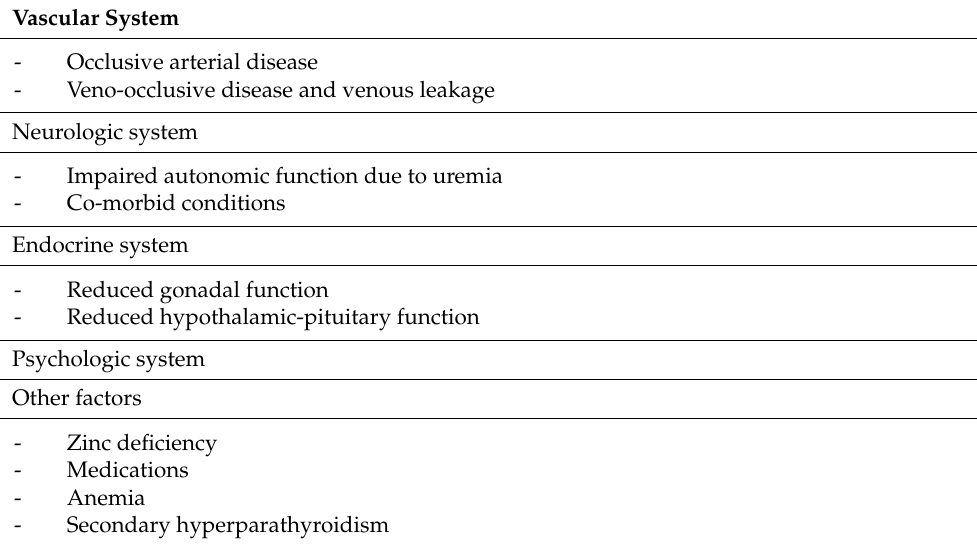
Table 1. Factors involved in the pathogenesis of erectile dysfunction in uremic men.